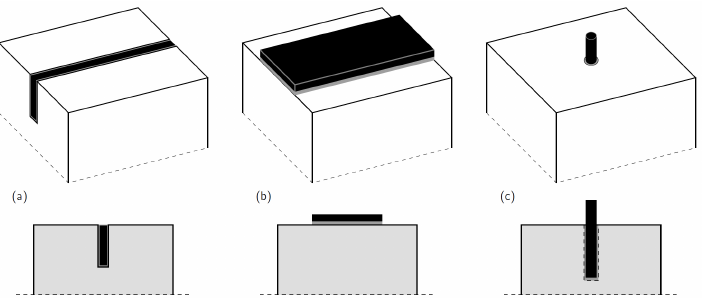
Figure 1. Sketch of strengthening techniques. ( a ) Near-surface mounted (NSM), e.g., at [58], ( b ) Externally bonded reinforcement (EBR), e.g., at [30], ( c ) Glued-in-rods (GiR), e.g., at